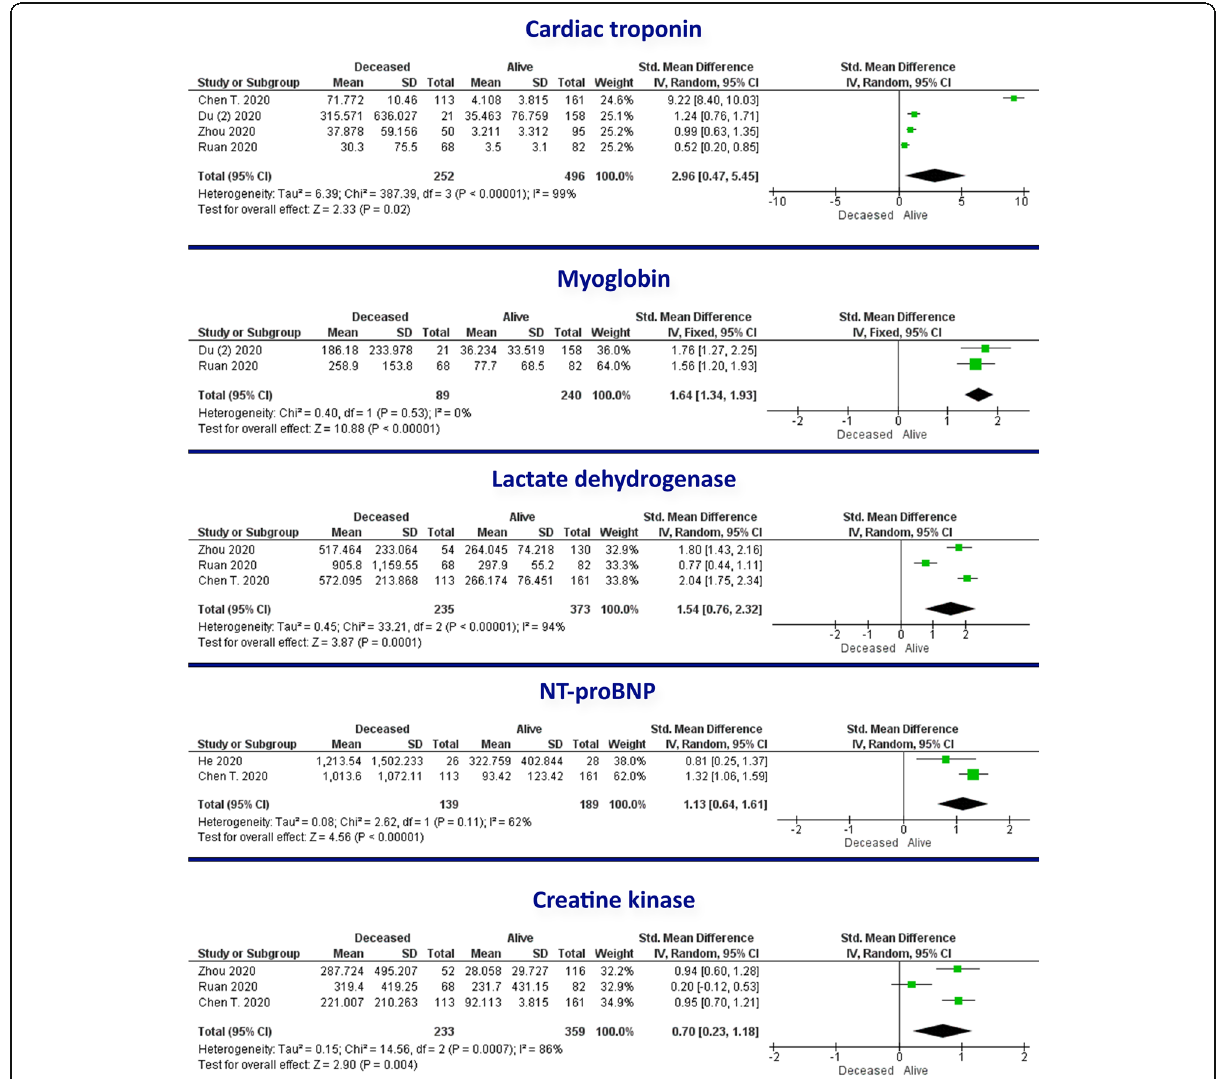
Fig. 5 Forest plots showing the standardized mean difference of cardiac biomarkers (troponin, myoglobin, LDH, NT-proBNP and CK) in the severe or ICU group compared with patients in the non-severe or non-ICU